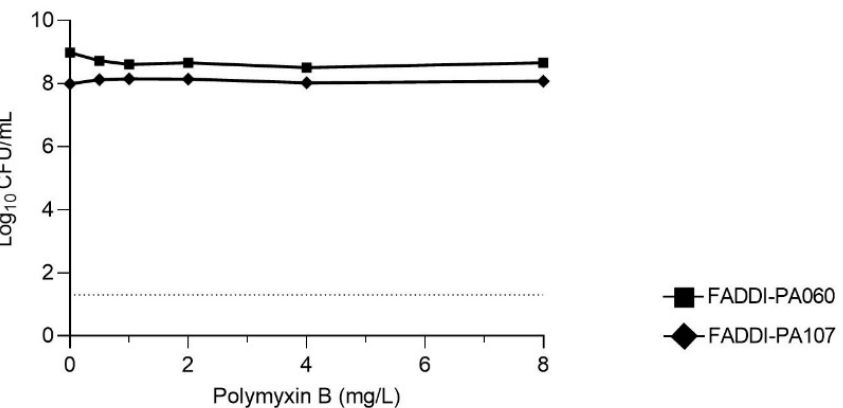
Figure 3. Baseline population analysis profiles of FADDI-PA060 and FADDI-PA107 at an initial inoculum of ~10 8 CFU/mL. The limit of detection is shown by the dotted horizontal line at 1.30 log 10 CFU/mL.